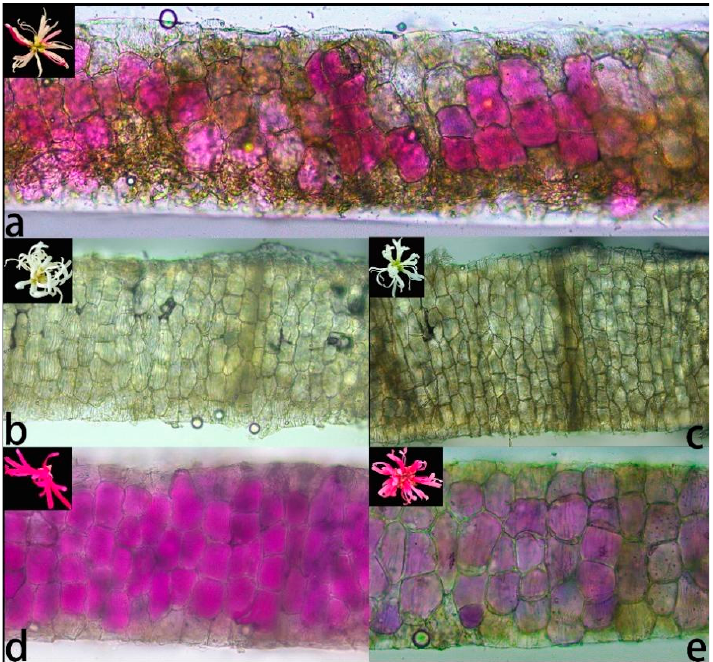
Figure 5. The distribution pattern of anthocyanins in flower of L. chinense var. rubrum. Note: ( a ) polychromatic group; ( b ) green-white group; ( c ) yellowish white group; ( d ) purplish red group; ( e ) purplish pink group.